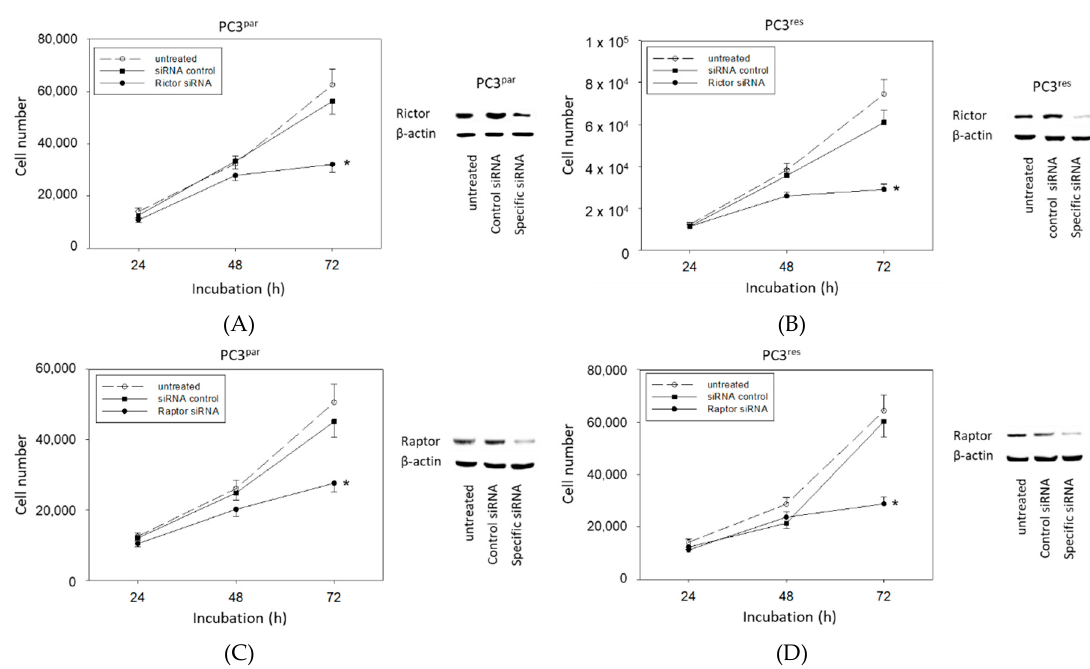
Figure 6. Cell growth after functional blocking with small interfering RNA (siRNA) targeting cdk1 and cyclin B of ( A ) PC3 par and ( B ) PC3 res cells. Controls remained untreated. Lower panel: Protein expression profile of cdk1 and cyclin B after functional blocking with siRNA. β -actin served as internal control. One representative of three separate experiments is shown. * indicates significant difference to control.